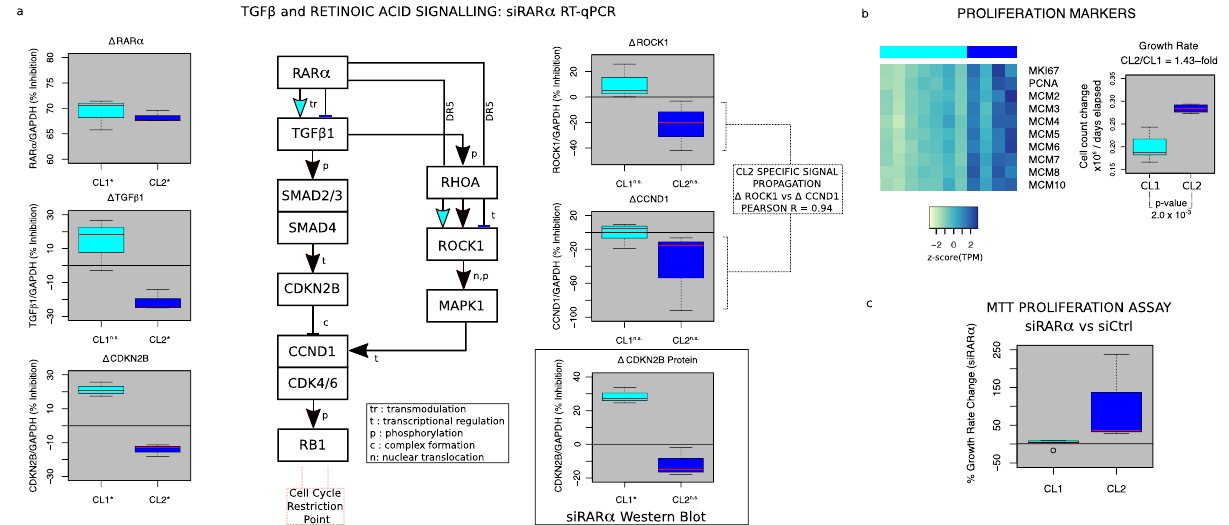
Fig. 4 | RAR α divergently regulates TGF β signaling and proliferation in a cluster-speci fi cmanner:transcriptionalandfunctionalvalidation.a siRAR α RT- qPCR on CL1 and CL2 RA FLS. Boxplots of change in mRNA levels under RAR α depletion (CL1: p =0.041, CL2: p =0.015) for TGF β 1 (CL2: p =0.004) and canonical CDKN2B(CL1: p =0.0009,CL2: p =0.0002)/non-canonicalsignalingaxisgenesthat undergotranscriptionalregulation.Arrows( ↑ )illustrateactivatingandbluntended lines(T)inhibiting/repressiveeffects.Cyanin fi lldepictstheprimaryCL1regulation logic, dark blue representing the primary CL2 regulation logic and black arrows representing both CL1 and CL2 logic. Boxplot of change in CDKN2B protein levels under RAR α depletion (CL1: p =0.048). p -values calculated by paired